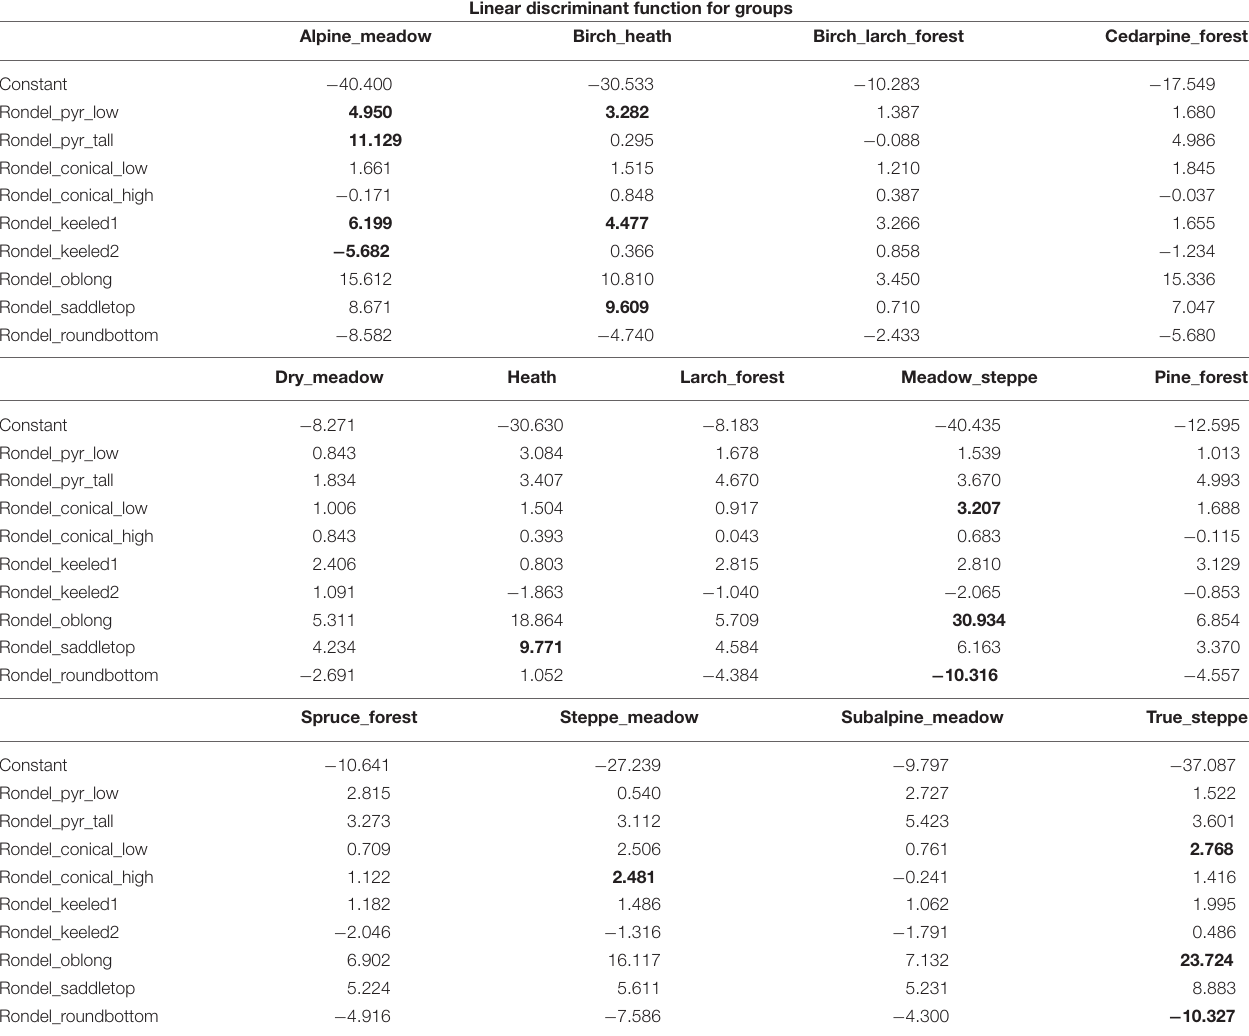
Linear discriminant function for